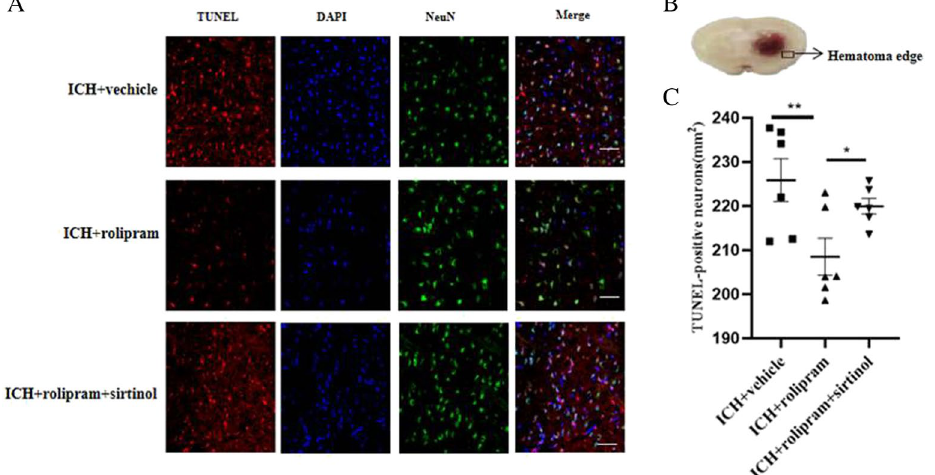
Figure 4. Rolipram attenuated neuronal apoptosis after ICH. ( A ) Representative TUNEL/NeuN photomicrographs in the different groups (scale bar = 20 µm). Fluorescence colours: TUNEL (red), DAPI (blue) and NeuN (green). ( B ) The box in the figure shows where apoptosis was measured. ( C ) Quantification of the numbers of TUNEL/NeuN-positive cells in the different groups. The Mann–Whitney U test was used to compare differences between groups in histological test. The data are presented as the means ± SEM. * p < 0.05, ** p <